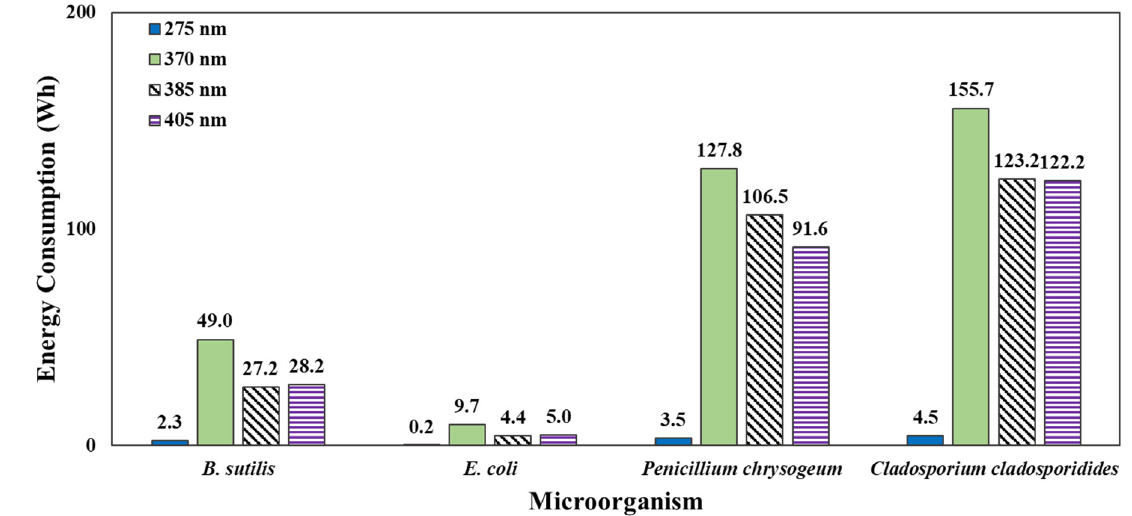
Figure 8. Energy consumption to achieve the 99.9% inactivation of four microorganisms by wave- length.